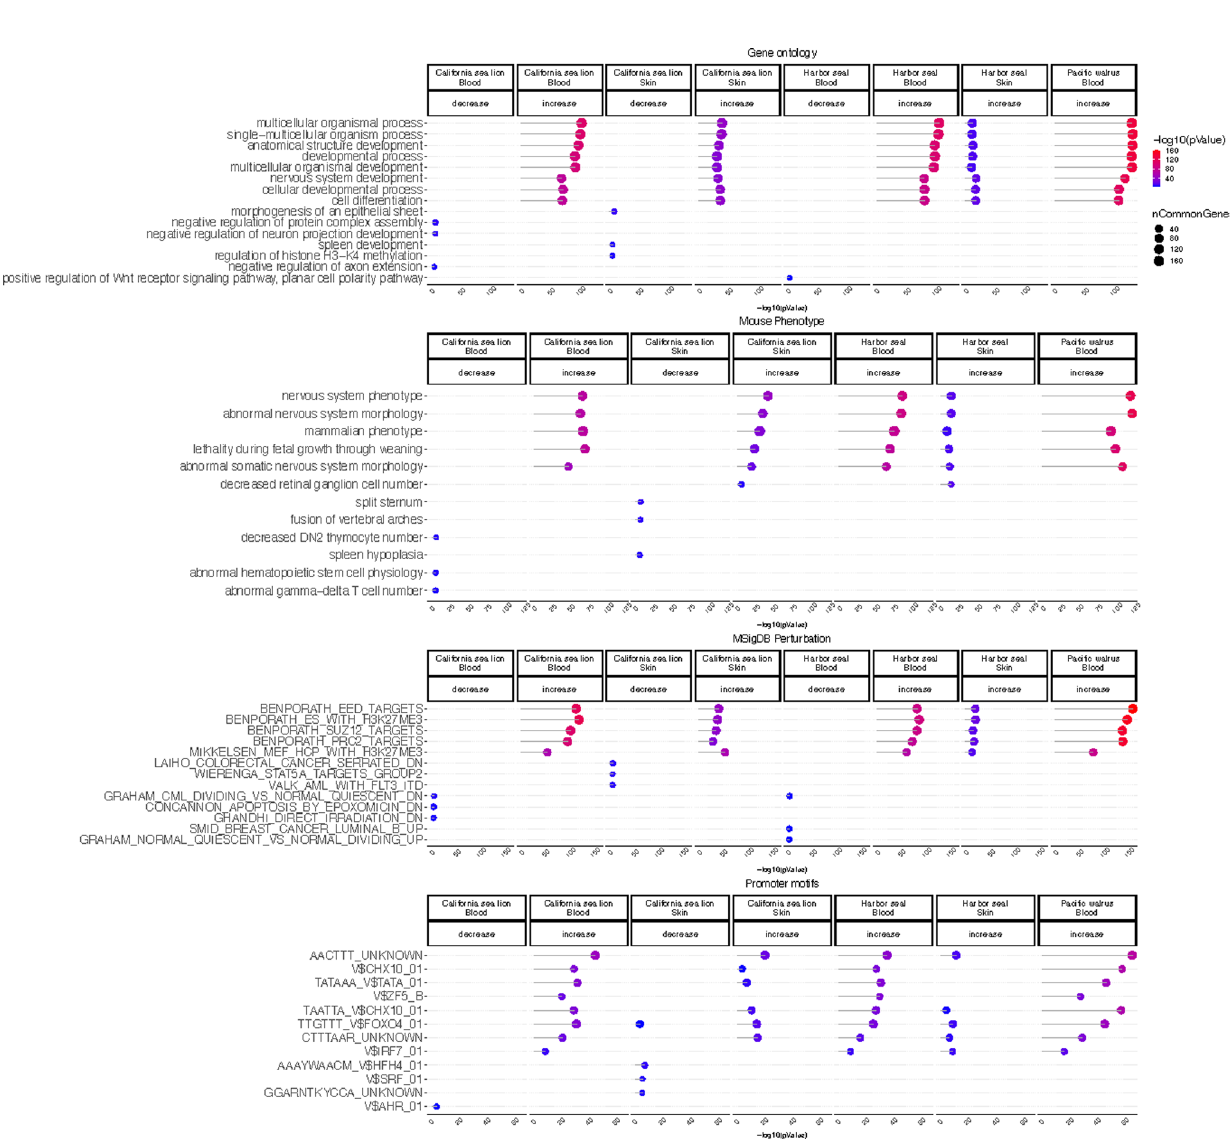
Fig. 4 Age-related methylation changes in gene regions, CpG islands and chromatin states of pinniped species. a Location of top CpGs in each tissue relative to the closest transcriptional start site. The odds ratio of the observed proportional changes occurring when compared to the background are reported in each bar. Fisher exact p values: * p < 0.05, ** p < 0.01, *** p < 0.001, **** p < 0.0001. b Box plot represents 25th and 75th percent quartiles, the line represents the median, and whiskers are 90% of aging association strati fi ed by CpG island status in pinniped species. The x axis is the Fisher transformed z score of the Pearson correlation of each CpG with age. Student ’ s t test p values are labeled above the box plots. c Enrichment of the chromatic states for age-related CpGs in pinnipeds. The chromatin states are based on the StackHMM, which reports the universal chromatin states in humans 68 . The p values were calculated with the hypergeometric test of the EWAS results with CpGs that are in each chromatin state. The background was limited to the CpGs that could be aligned to all three pinniped genomes. The PRC2 state was de fi ned based on the binding motif for any polycomb repressor complex 2 transcription factor (EED, SUZ12, EZH2) in human tissues.